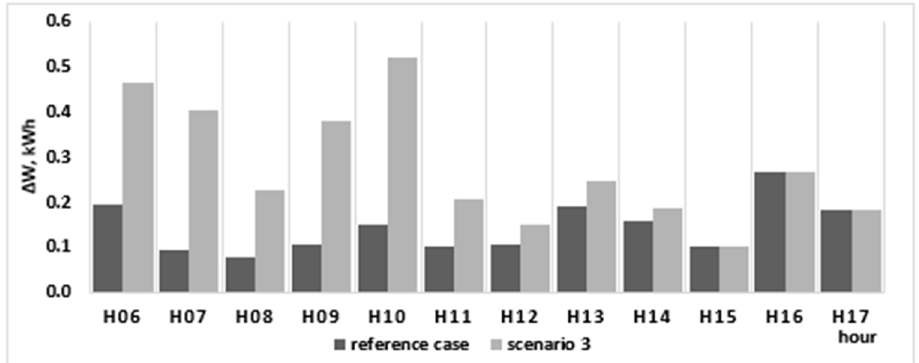
Figure 15. The energy loss pattern at battery charging hours, Scenario 3.